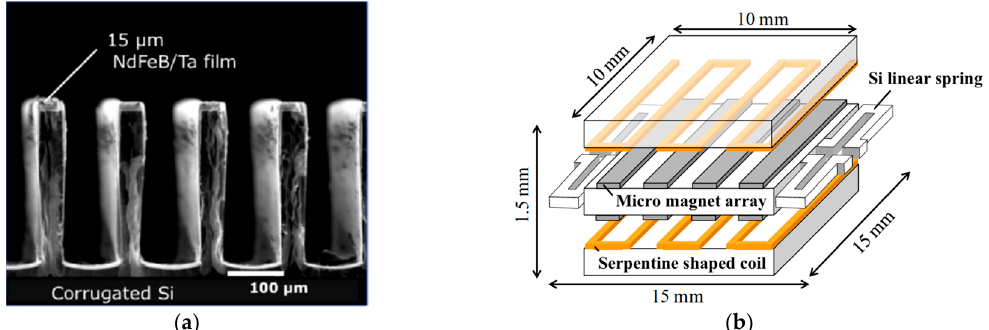
Figure 1. ( a ) SEM photograph of sputtered NdFeB/Ta multilayer film on 300 µm depth corrugated silicon; ( b ) Orthogonal schematic diagram of double-sided NdFeB magnetic film energy harvester.